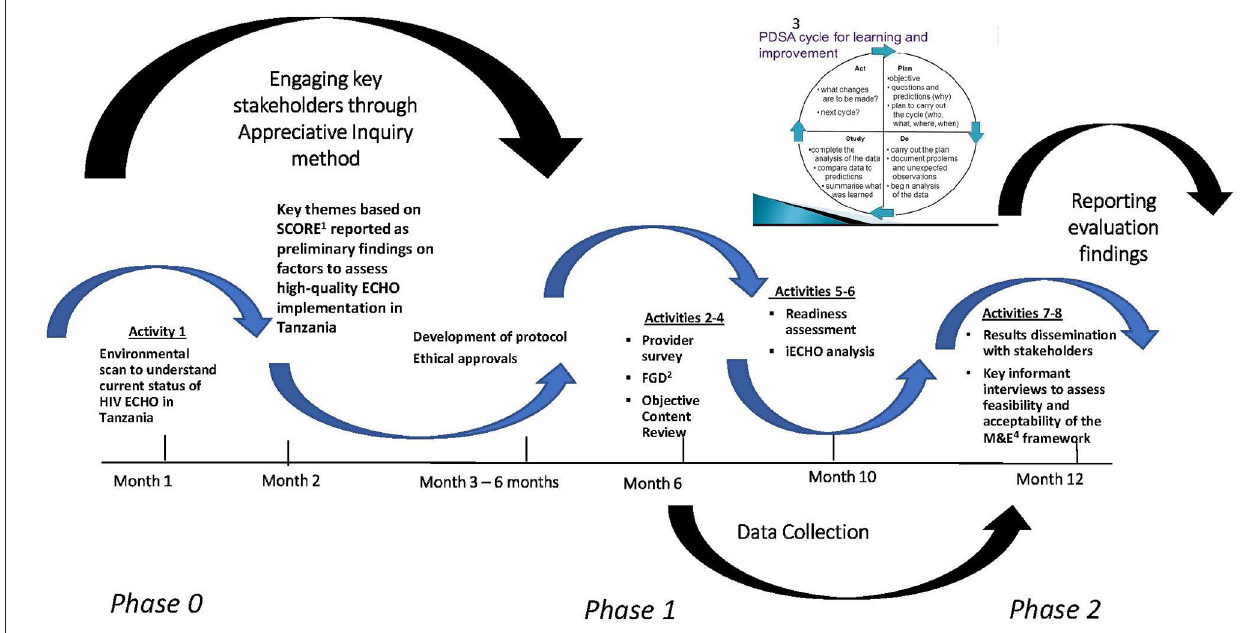
FIGURE 1 | Evaluation implementation phases. 1 SCORE, Strengths, Challenges, Opportunities/Aspirations, Measurable Results, Evaluation; 2 FGD, Focus group discussions; 3 PDSA, Plan, Do, Study, Act; 4 M&E, Monitoring and